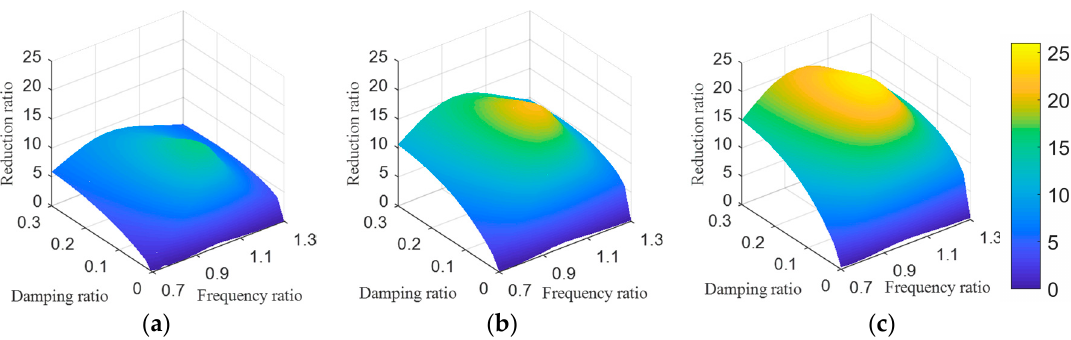
Figure 23. Reduction ratio over damping ratio and frequency ratio. ( a ) Mass ratio = 0.02; ( b ) Mass ratio = 0.04; ( c ) Mass ratio = 0.063.